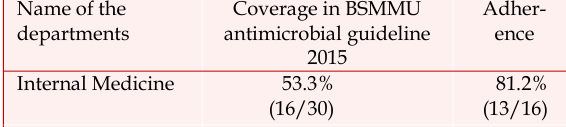
Proportion of diseases mentioned in BSMMU antimicrobial guideline 2015 and rate of guideline adherence Name of the